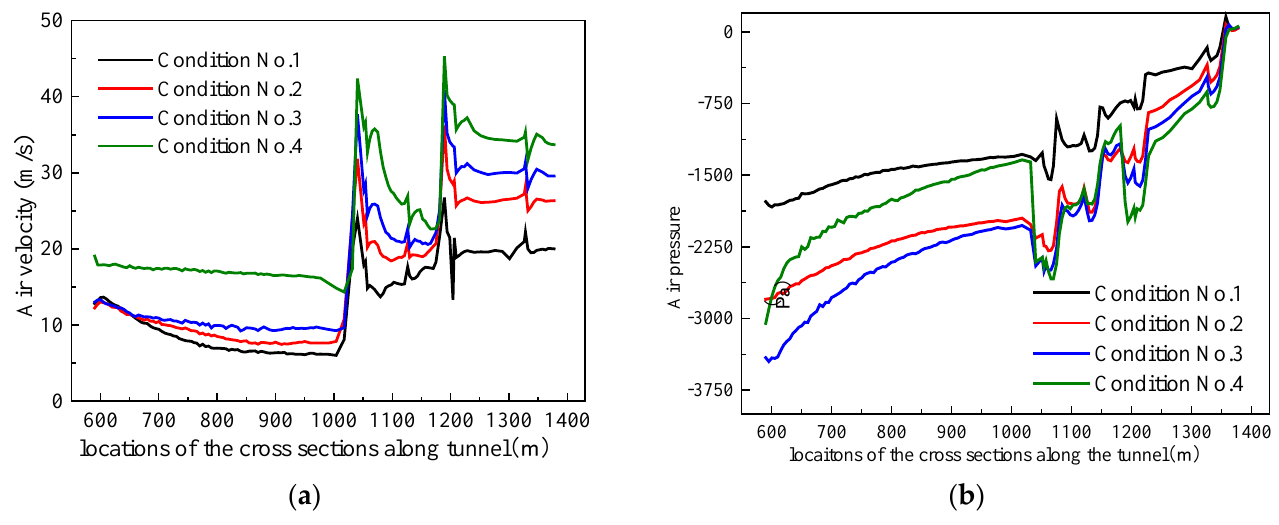
Figure 12. The ( a ) average air velocity and ( b ) average air pressure over the cross-sections in the